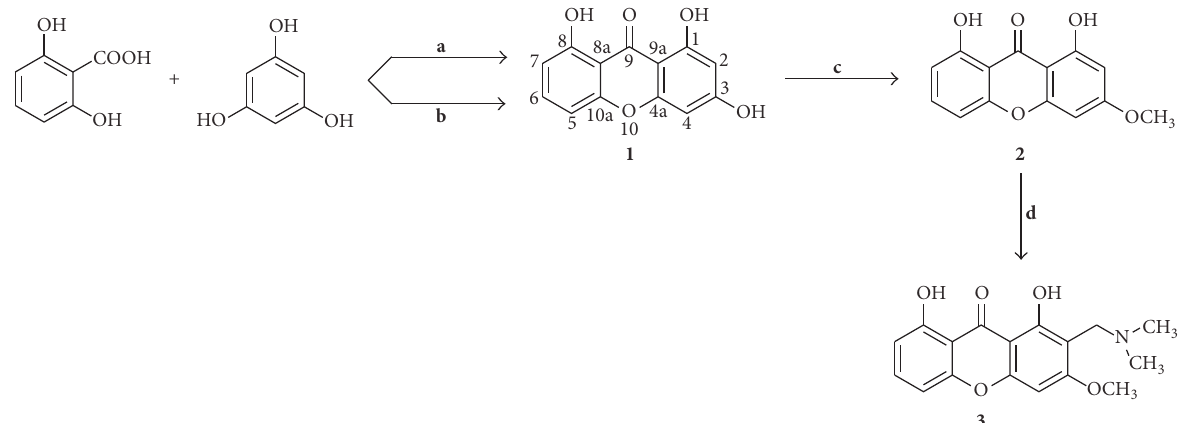
Scheme 1: Reagents and conditions for the synthesized xanthones 1 , 2 , and 3 . ( a ) Eaton’s reaction: P 2 O 5 /CH 3 SO 3 H, 90 ∘ C, 30 min; 2,6- dihydroxybenzoic acid/phloroglucinol, 80 ∘ C, 1h; ( b ) GSS reaction: (i) ZnCl 2 , POCl 3 , MW (400W), 60 ∘ C, 10min; (ii) 2,6-dihydroxybenzoic acid, MW (400W), 60 ∘ C, 10min; (iii) phloroglucinol, MW (400 W), 60 ∘ C, 60min; ( c ) CH 3 I, K 2 CO 3 , 60 ∘ C, 3 h; ( d ) Mannich reaction: (i) dimethylamine/HCHO/CH 3 COOH, room temperature, 1h; (ii) addition of xanthone 2 , room temperature, 6 days. The numbering